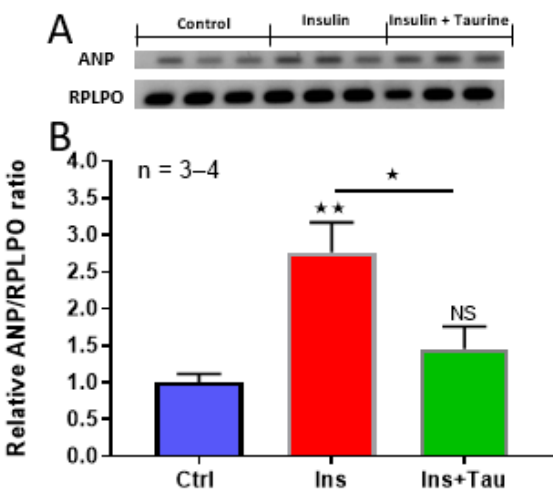
Figure 3. RT-PCR showing the effect of a 48-h treatment with insulin (80 µ U/mL) and insulin (80 µ U/mL) with taurine (20 mM) on the relative ANP/RPLPO ratio of ventricular cardiomyocytes. ( A ): Autoradiography showing the levels of ANP of ventricular cardiomyocytes in the absence of treat- ment, treated with insulin (80 μ U/mL) and treated with insulin (80 μ U/mL) + taurine (20 mM). ( B ): The statistical comparison of the relative ANP/RPLPO ratio was calculated using the densitometric measurements of the corresponding bands. The values are represented as mean ± standard error of the mean. n represents the number of wells. * p < 0.05 and ** p < 0.01. ANP = atrial natriuretic peptide; RPLPO = large ribosomal protein P0; NS= non-significant. 3.2. Modulation of Cytosolic and Nuclear Sodium Levels by Insulin, Insulin + Taurine, and Insulin + Taurine + β -Alanine in Ventricular Cardiomyocytes The purpose of this series of experiments was to verify whether the increase in cell volume by chronic treatment with insulin modulates the resting levels of intracellular so- dium and whether the preventive effect of taurine on this hypertrophy was modulated via preventing intracellular sodium overload. In the first series of experiments, after 48 h of treatment with insulin (80 μ U/mL), the cells were loaded with sodium fluorescence probes, CoroNa green, and sodium green. Figure 4A–B shows examples, and Figure 5 summarizes the results. As shown in these two figures, there was a significant increase in the whole cell ( p < 0.0001), as well as in the cytosol ( p < 0.05) and nucleus ( p < 0.01) sodium levels that were associated with an appar- ent increase in the whole cell (Figure 4B) and nuclear volumes (Figure 4F) when compared to non-treated cardiomyocytes (Figure 4A,E). In addition, the nucleus of each cell was labeled with Syto-11 (Figure 4E,F) to locate its position with respect to the whole cell (Fig- ure 4A,B). Using the same protocol, the cells were treated for 48 h with insulin (80 μ U/mL) + taurine (20 mM) in another series of experiments. Figure 4C,G show examples, and Figure 5 summarizes the results. As shown in Figure 4A–C, the prevention of insulin-induced hypertrophy by taurine was accompanied by the prevention of insulin-induced increase in cytosolic and nuclear sodium levels (Figures 4C and 5) compared to the non-treated cells (Figures 4A and 5). However, as shown in Figure 5, there was no significant increase in the intracellular sodium levels in the whole-cell (Figure 5A), cytosol (Figure 5B), and nucleus volumes (Figure 5C). In the last series of experiments, using the same protocol, the cells were treated for 48 h with insulin (80 μ U/mL) + taurine (20 mM) + β -alanine (500 μ M). Figure 4 shows examples, and Figure 5 summarizes the results. As seen in Figure 4, β -alanine’s presence prevented the effect of taurine on the insulin-induced increase in intracellular sodium (Figure 4D) compared to non-treated cells (Figure 4A). In addition, Figure 5 shows the presence of β -alanine significantly prevented taurine from decreasing an insulin-induced